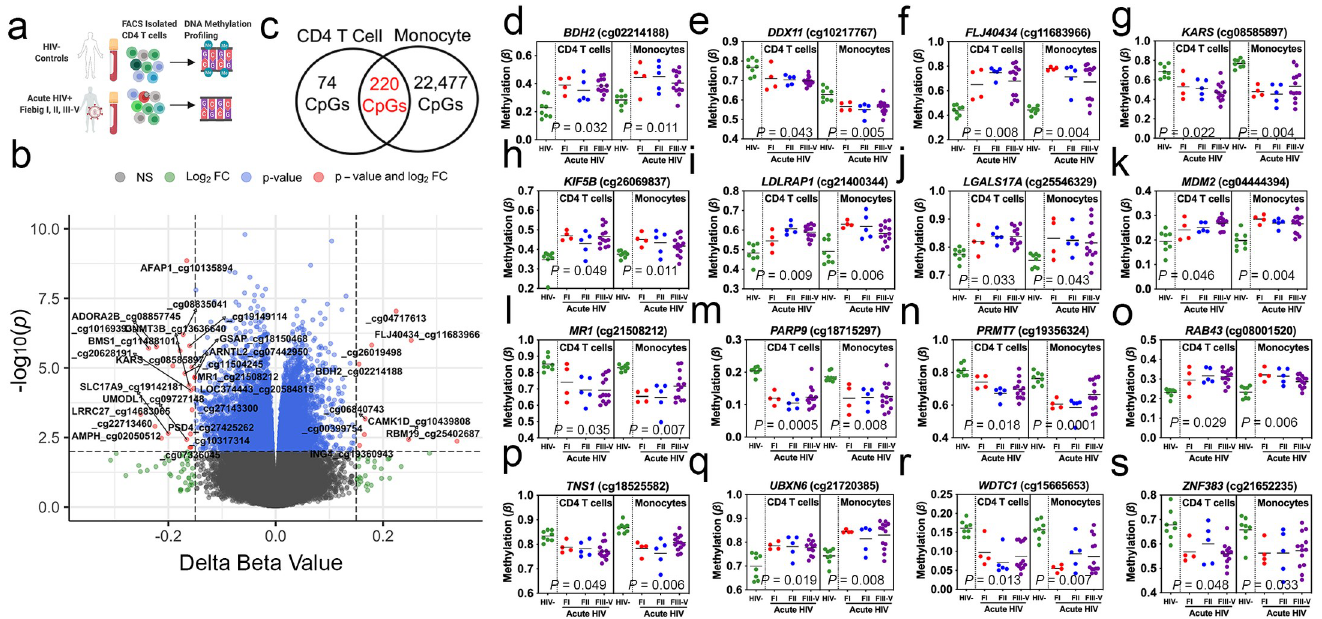
Fig 3. Cell-type independent differentially methylated loci associated with acute HIV infection. (a) Diagram of experimental design displaying comparison utilized to identify DML in CD4+ T cells associated with AHI. Created with BioRender.com (b) Volcano plot displaying gene symbol and CpG ID (cg#) for top hypomethylated and hypermethylated sites associated with AHI in CD4 + T lymphocytes. Difference in DNA methylation displayed as delta beta values plotted against P values transformed using -log10(P). (c) Venn diagram displaying the number of overlapping DML and cell-type specific DML identified in CD4+ T cells and monocyte cells (d-s) Plots demonstrating changes in DNA methylation in AHI Fiebig I (red dots), Fiebig II (blue dots) Fiebig III-V (purple dots) participants compared to HIV- (green dots) at single CpGs sites related to annotated protein-coding genes displayed in bold italic above CpG ID (cg#) for CD4 + T lymphocytes and monocytes. Significance determined comparing HIV- vs. AHI and using FDR adjusted P-values < 0.05.